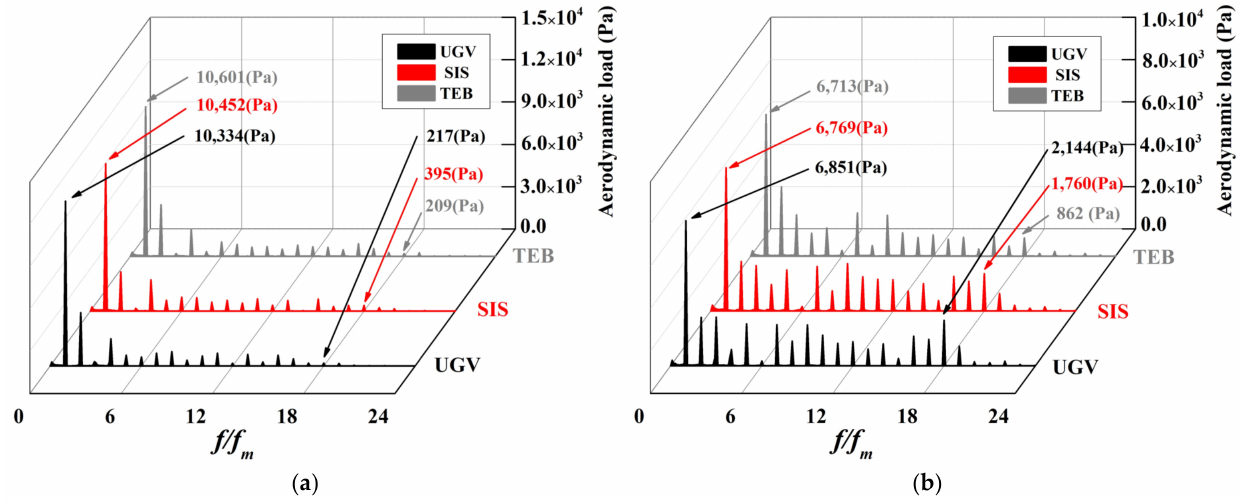
Figure 13. The aerodynamic load comparison of the frequency harmonic ( a ) P3 and S3, ( b ) P10 and S10 in different radial inlet